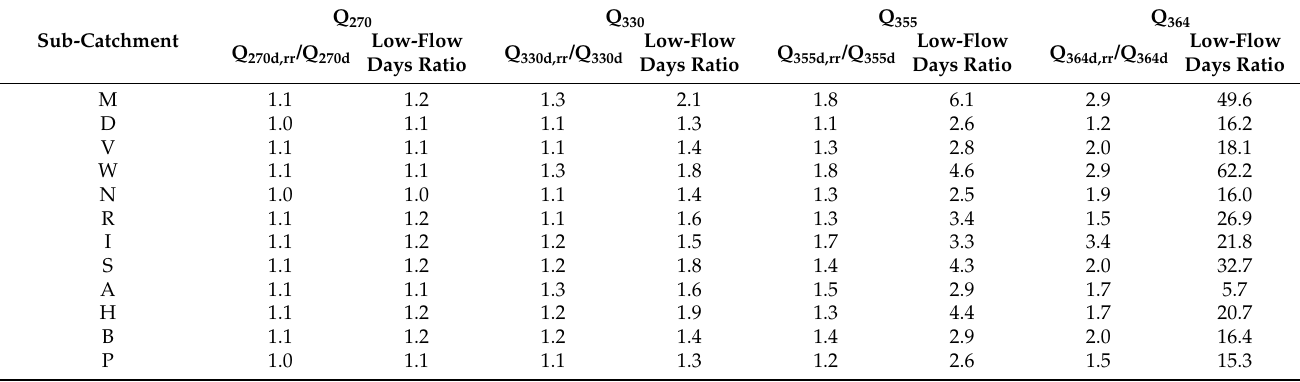
Table 3. Comparison of the ratios of limit values Q Md,rr /Q Md (1961–2000) and the ratios of related number of days of low-flow events; mean values for sub-catchments (1961–2015). Q 270 Q 330 Q 355 Q 364 Low-Flow Sub-Catchment Q 270d,rr /Q 270d Days